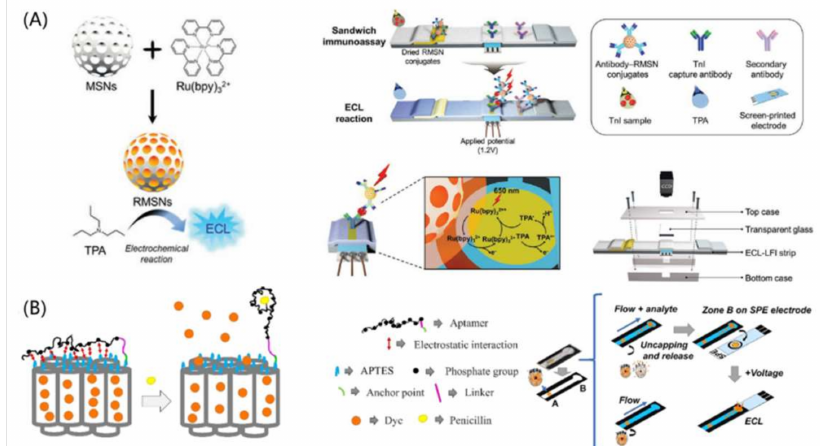
Figure 5. Silica-nanomaterial-assisted ECL-LFA. ( A ) [Ru(Bpy) 3 ] 2+ -loaded MSNs as ECL probes for sensitive and quantitative detection of troponin I. ( B ) MSN-based aptamer-gated indicator releasing strategy for antibiotic detection. Reprinted with permission from References